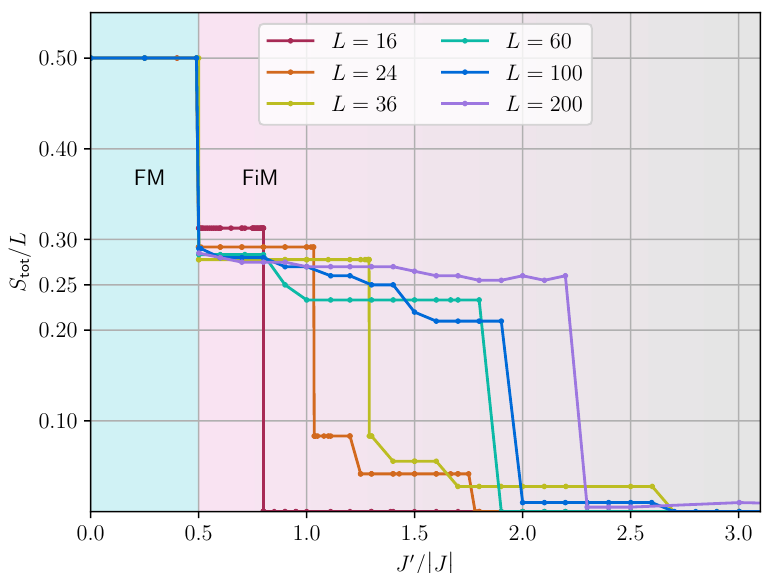
/ L for various finite systems with pe- tot ( S ) 0 tot